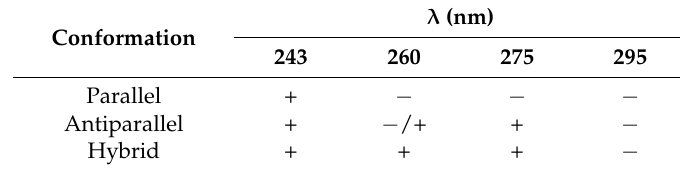
Table 1. Thermal denaturation profile of different conformations of G4.